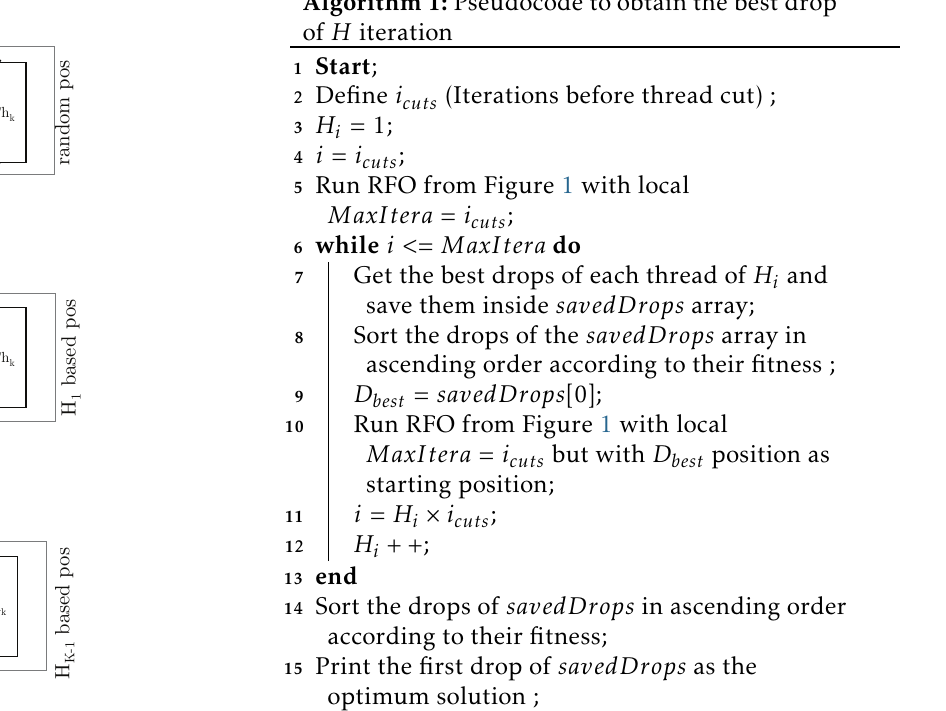
Figure 3. The threading process.